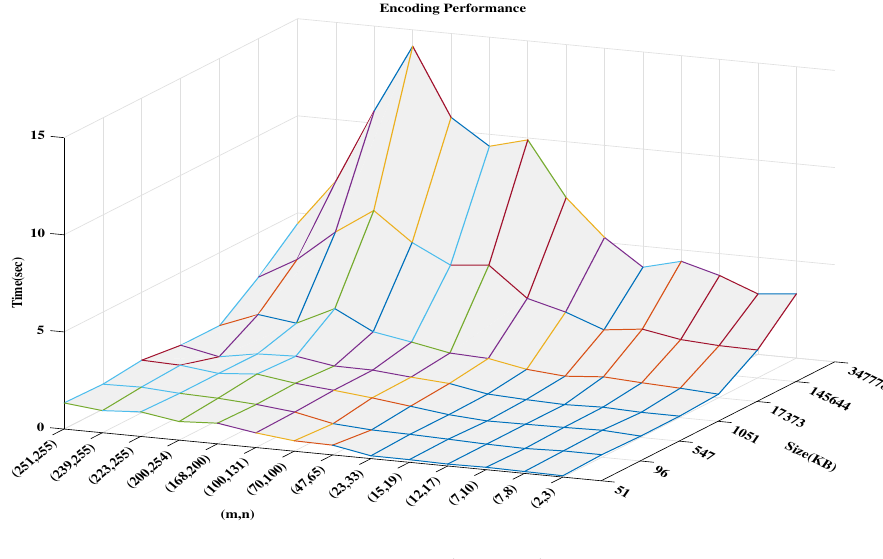
Figure 4. Encoding results.